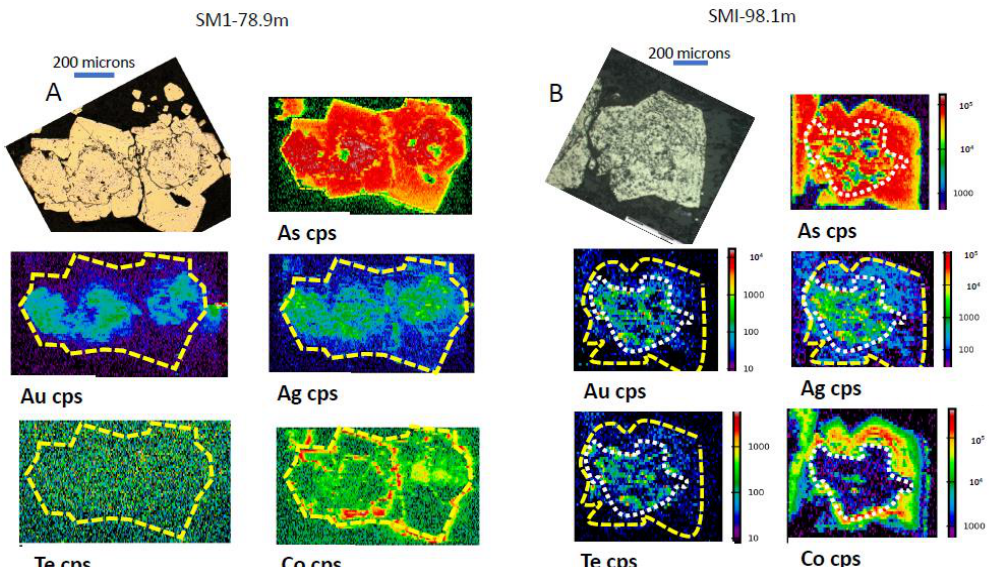
Figure 3. Two contrasting laser ablation inductively coupled mass spectrometer (LA-ICPMS) images in counts per second (cps) of pyrite from the Spanish Mountain deposit. ( A ) Au, As and Ag concentrated in the core (py1), and no Te. ( B ) Au, Te and Ag in the core (py1), with Co, As in the euhedral rim with no Au. Cold colours (blue, green) represent low concentrations; hot colours (yellow, orange, red) represent high concentrations.